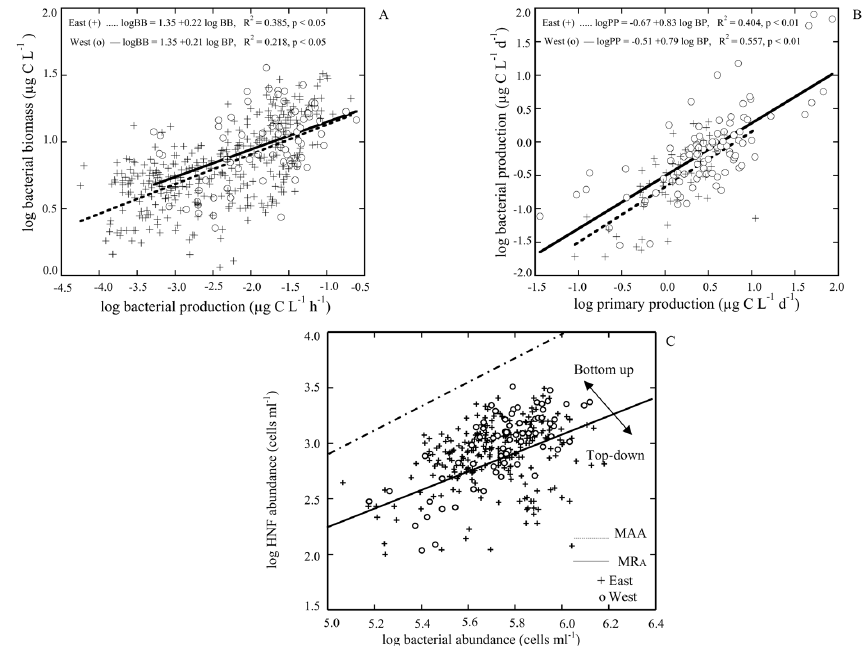
Fig. 14. (A) Log–log linear regression between bacterial biomass (µgCl − 1 ) and bacterial production (µgCl − 1 h − 1 ) and (B) between bacterial production and primary production (µgCl − 1 d − 1 ) for the WMS and EMS waters; (C) Relationship between log heterotrophic nanoflagellates abundance (HNF, cellsml − 1 ) and log bacterial prey (cellsml − 1 ) from the model of Gasol (1994). All HNF abundances fall below the Maximum Attainable Abundance line (MAA) while 70 and 75% HNF fall above the Mean Realized Abundance for marine environment (MRA) in the EMS and WMS, respectively, generally suggesting bottom-up control prevailing on HNF (cf. open sea studies on Table